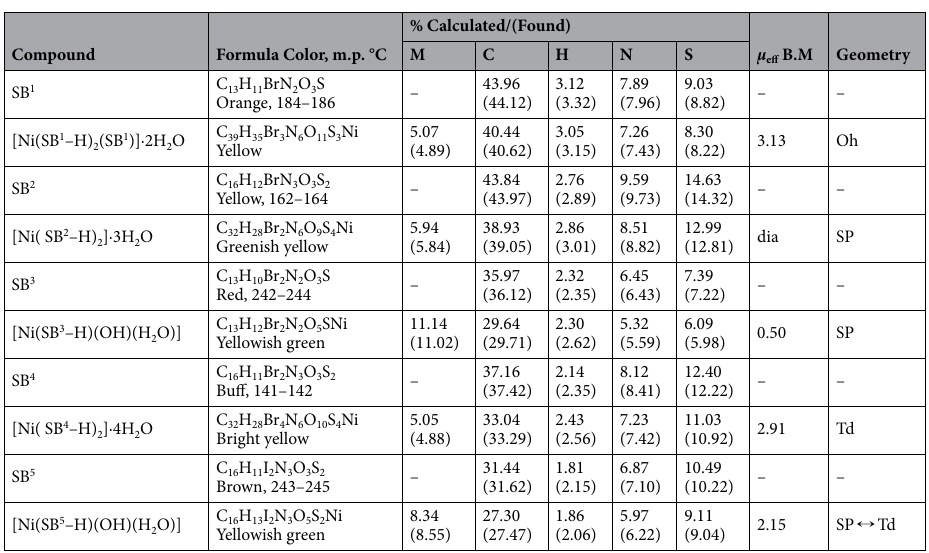
Compound Formula Color, m.p.